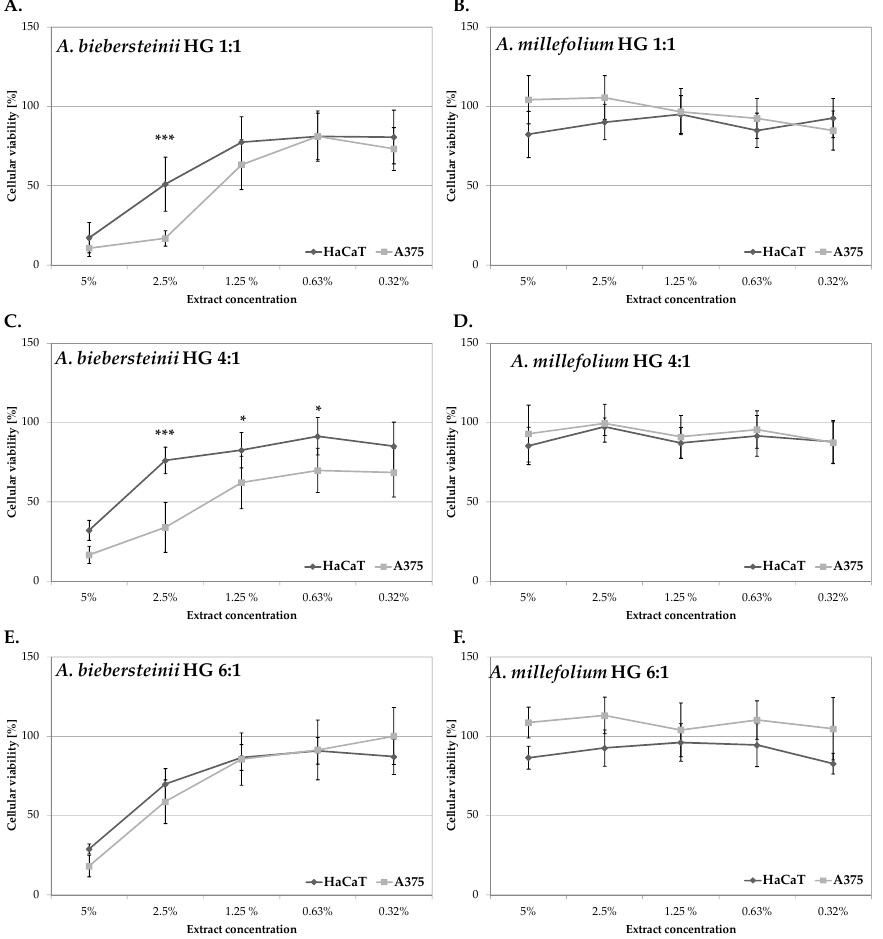
Figure 2. In vitro cytotoxicity of A. biebersteinii ( A , C , E ) and A. millefolium ( B , D , F ) extracts against human keratinocytes HaCaT and A375 human malignant melanoma cell lines; values on graphs represent mean ± SD ( n = 3 ); * p < 0.05, *** p < 0.0001.